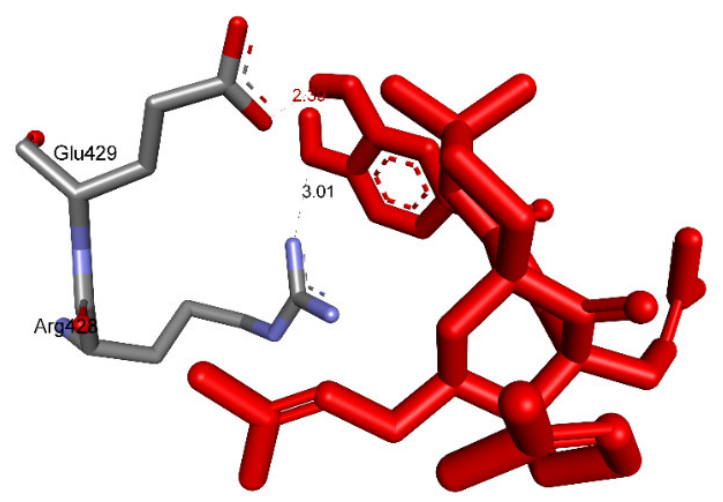
Figure 3. The hydrogen bonding formed from atoms on active pose 148 to atoms active on residual amino acids.